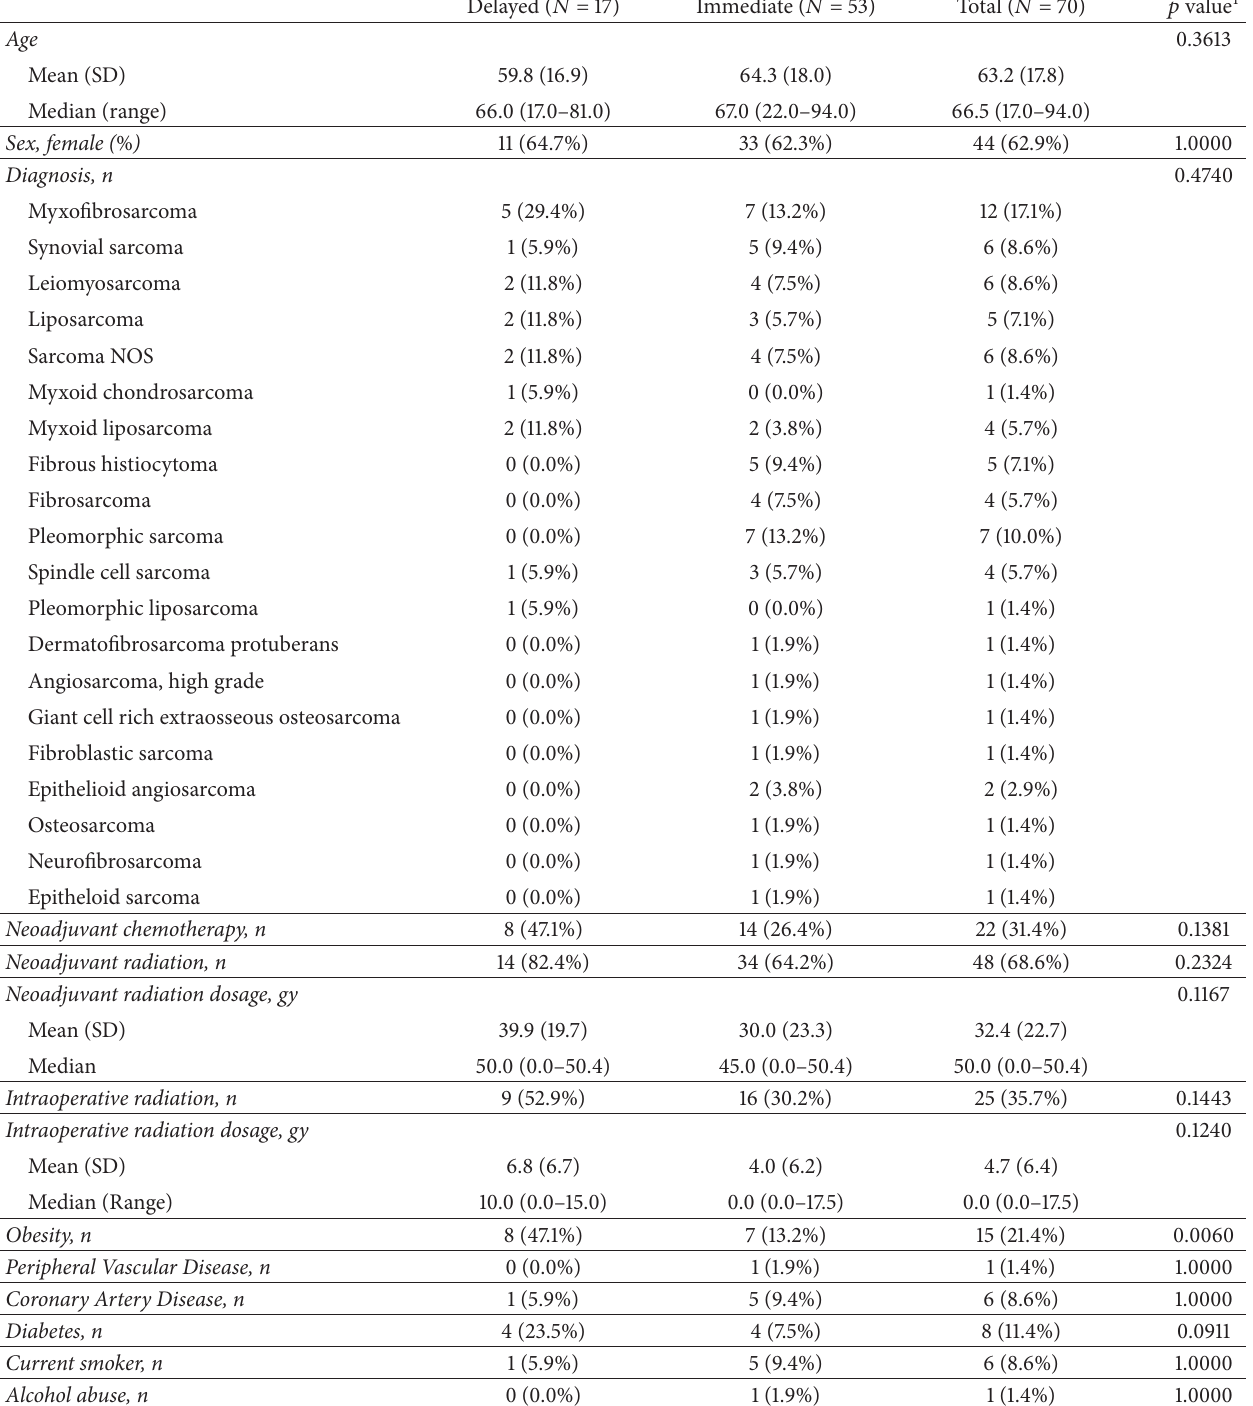
Table 1: Characteristics of the study population by reconstructive